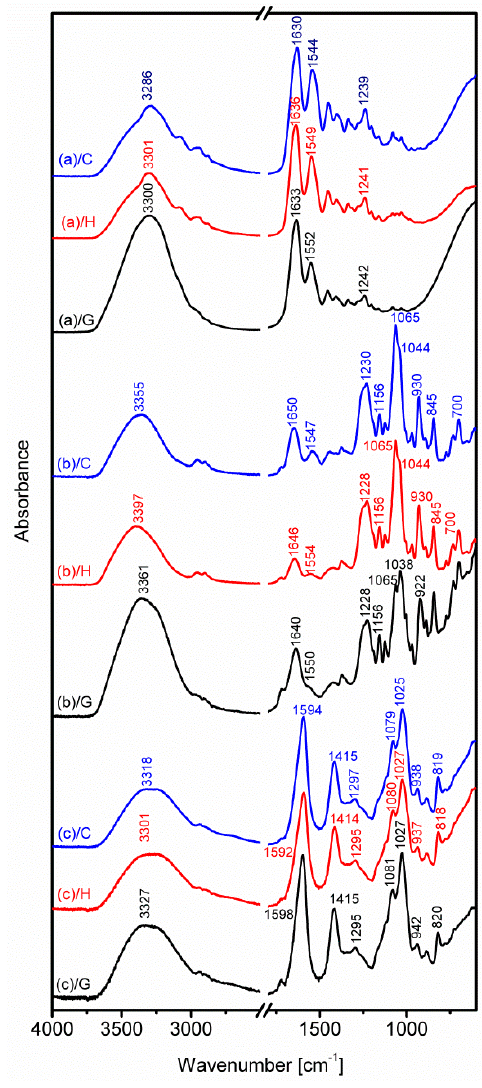
Figure 3. The FTIR spectra of: ( a ) 8% ( w / v ) gelatine + 0.2% ( w / v ) NaCl, ( b ) 2.5% ( w / v ) carrageenan + 0.2% ( w / v ) NaCl and ( c ) 1.25% ( w / v ) sodium alginate + 0.2% ( w / v ) NaCl in three variants of the gels: C, H, G (see the description in the text). Only discussed bands are labelled.